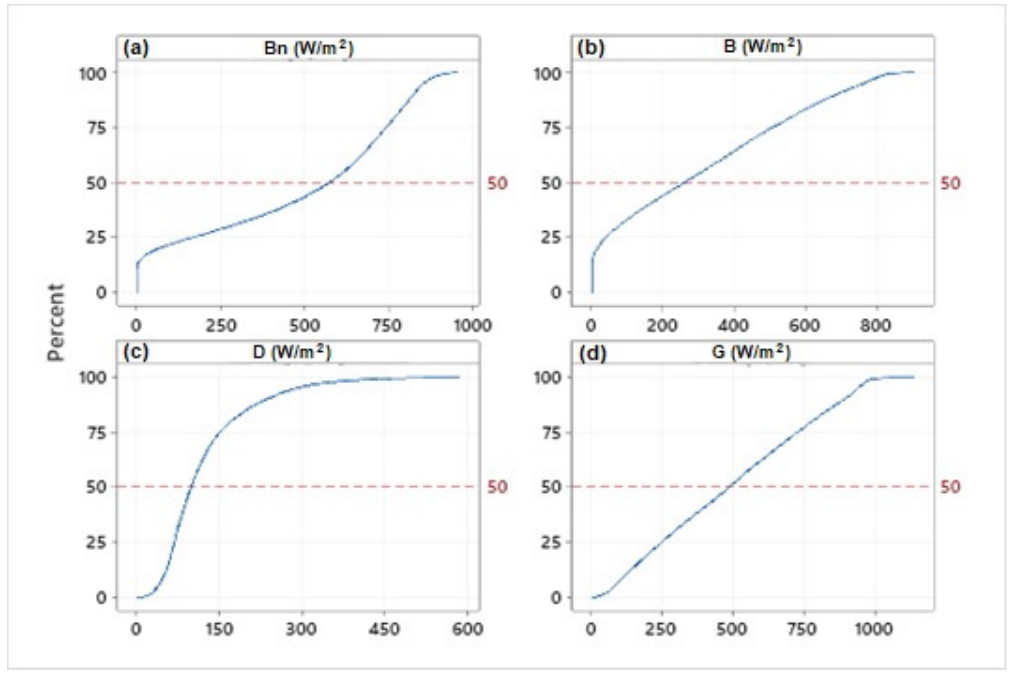
Figure 18. Cumulative frequency distribution (CDF) of shortwave solar radiation components: ( a ) direct normal ( B n ); ( b ) direct horizontal ( B ); ( c ) diffuse ( D ); and ( d ) global ( G ) irradiances (W/m 2 ).